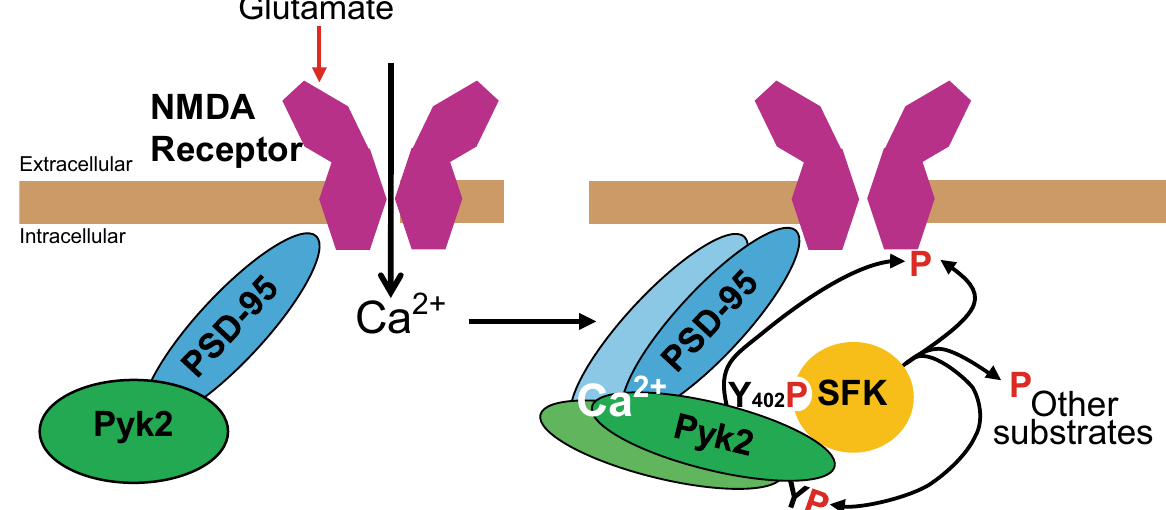
Figure 5. Schematic representation of Pyk2 activation at synapses. Pyk2 is associated with NMDA receptors (NMDAR) through its interactions with PSD proteins such as PSD-95. Following Ca 2+ entry through activated NMDAR, Pyk2 is activated, presumably by intermolecular autophosphorylation promoted by interaction of Ca 2+ and calmodulin (not shown) with Pyk2 and/or associated PSD-95. Autophosphorylated Tyr-402 in Pyk2 provides a binding site for the Src-homology domain 2 (SH2) of Src-family kinases (SFKs) such as Fyn or Src. SFKS also interact with Pyk2 through their SH3 domain (details not depicted in the cartoon). This results in the activation of SFKs which can phosphorylate various tyrosine residues in Pyk2 and increase its kinase activity. SFKs and presumably Pyk2 phosphorylate NMDAR on tyrosine, which increases NMDA currents, at least in part by increasing NMDAR at the cell surface. In addition, SFKs and Pyk2 can phosphorylate other substrates and activate various signaling pathways that have not yet been fully characterized at the post-synaptic level. See the text for